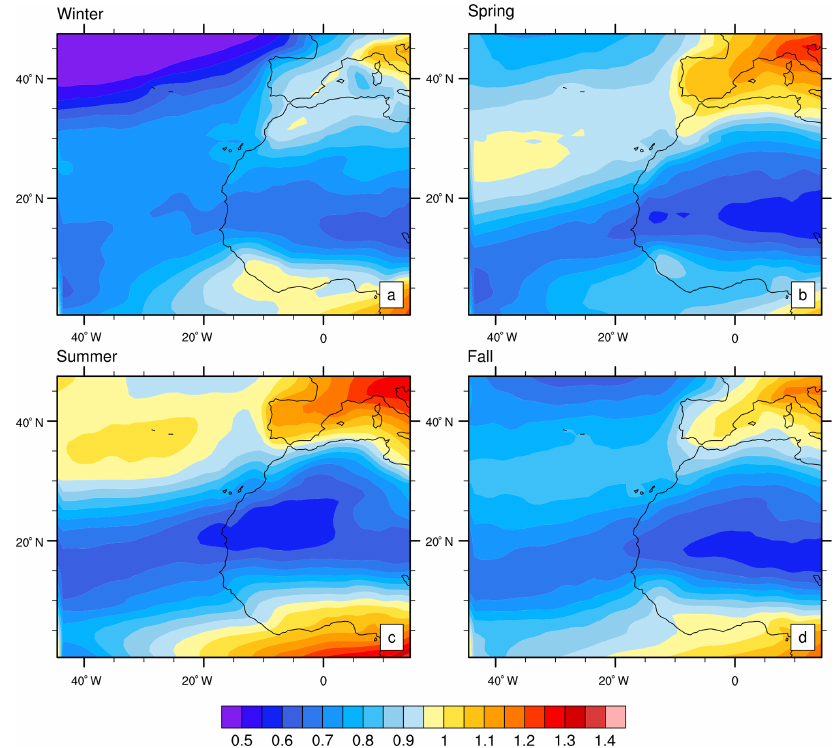
Figure 3. Aerosol Ångström exponent from MACC in (a) winter, (b) spring, (c) summer, and (d) fall.